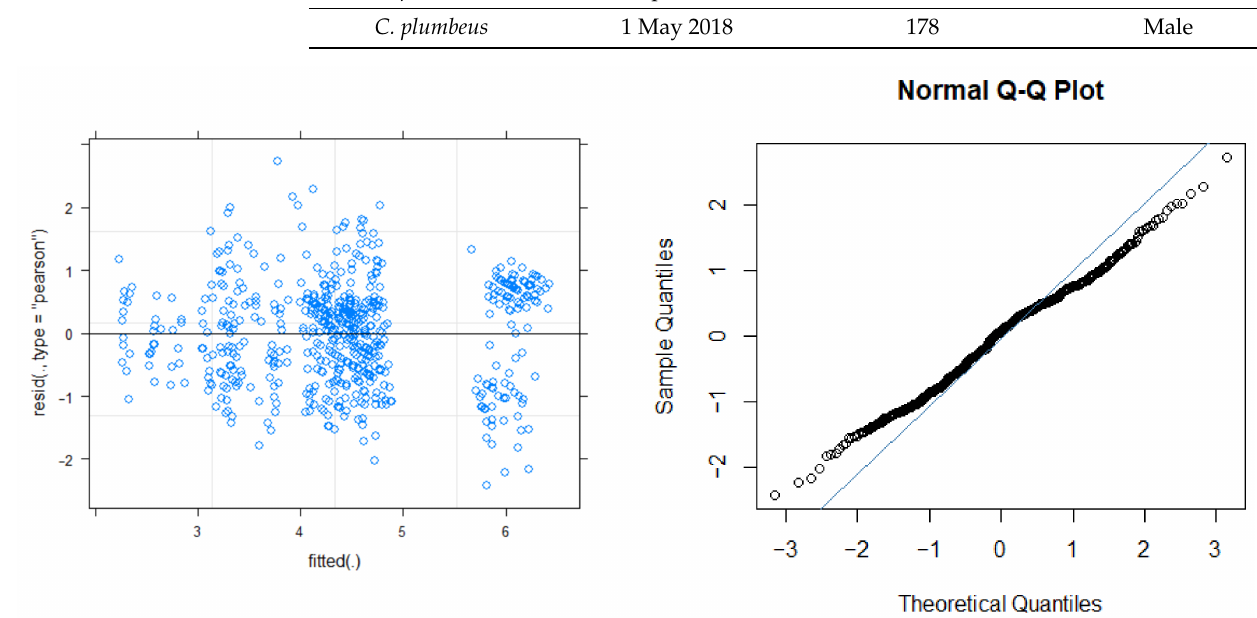
Figure A2. Residuals distribution for the LM